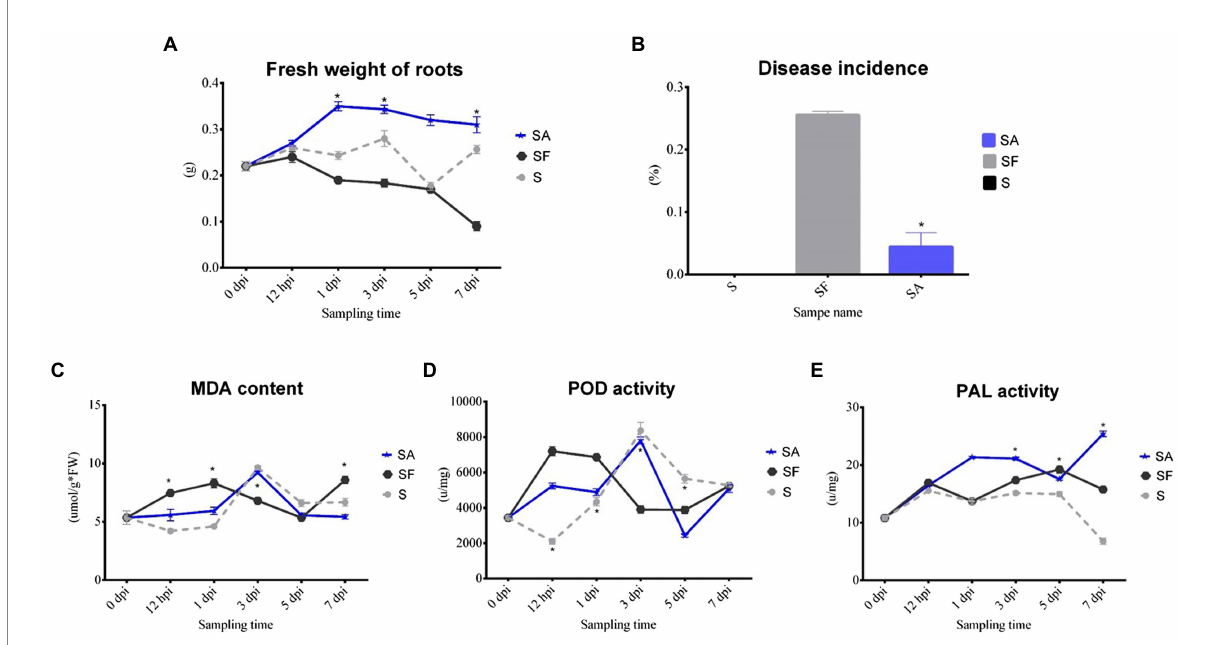
FIGURE 2 Comparison of physiological changes, disease incidence, and biochemical indexes of watermelon plants after exogenous salicylic acid application. (A) Comparison of the root fresh weight of different samples. (B) Comparison of the disease incidence in different samples. (C) Comparison of the malondialdehyde (MDA) content in different samples. (D) Comparison of the peroxidase (POD) activity in different samples. (E) Comparison of the phenylalanine ammonia lyase (PAL) activity in different samples. S, Mock-inoculation control; SA, SA + FON treatment; SF, FON treatment; FON, Fusarium oxysporum f. sp. niveum ; SA, salicylic acid; hpi, hours post-inoculation; dpi, days post-inoculation; 0 dpi: before treatment. Three biological replicates per sample were analyzed. Data are expressed as mean ± SE ( n = 3). Multiple t -tests of ANOSIM (* p ≤